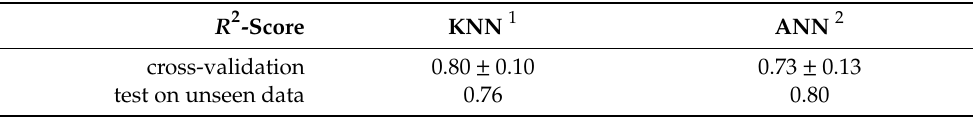
Table 4. Training and test scores of the KNN and ANN model; uncertainty measure is two times the standard deviation of the cross-validation process (equiv. to approx. 95% confidence